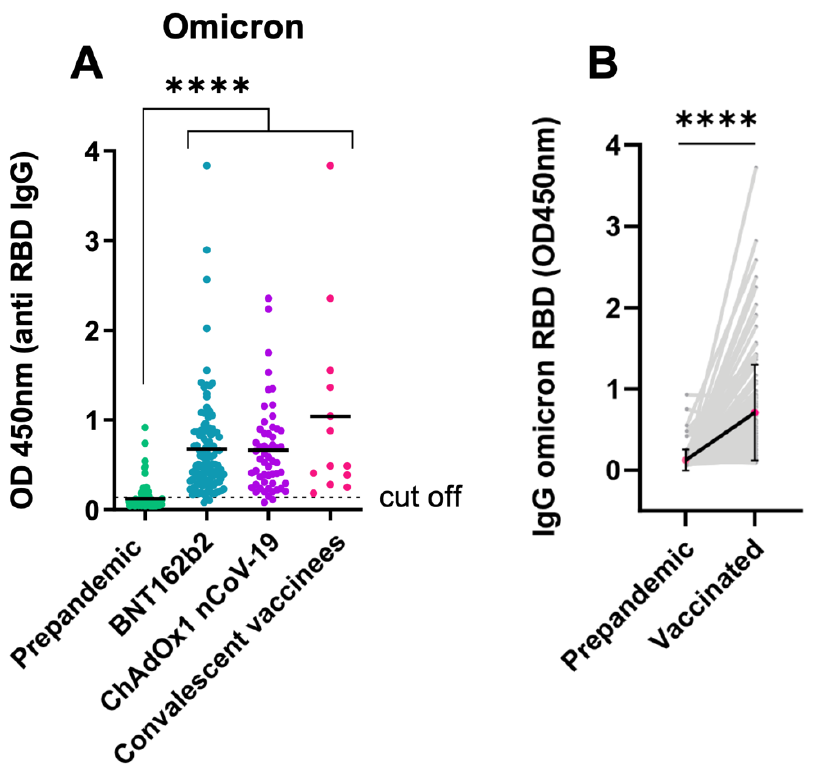
Figure 7. Cross-reactive IgG antibody levels could be found in several pre-pandemic sera but increased significantly after vaccination. ( A ) Anti-Omicron IgG increasing from the pre-pandemic status upon vaccination with BNT162b2 (Pfizer) or ChAdOx1 nCoV-19 (Oxford/AstraZeneca) vaccine and/or having undergone mild-to-moderate COVID-19 in healthcare workers. ( B ) Anti-Omicron-RBD IgG increase from pre-pandemic levels, exhibiting cross-reactivity and increase following vaccination with the BNT162b2 or ChAdOx1 nCoV-19 vaccines. For paired samples, Wilcoxon test was applied; **** p < 0.0001.